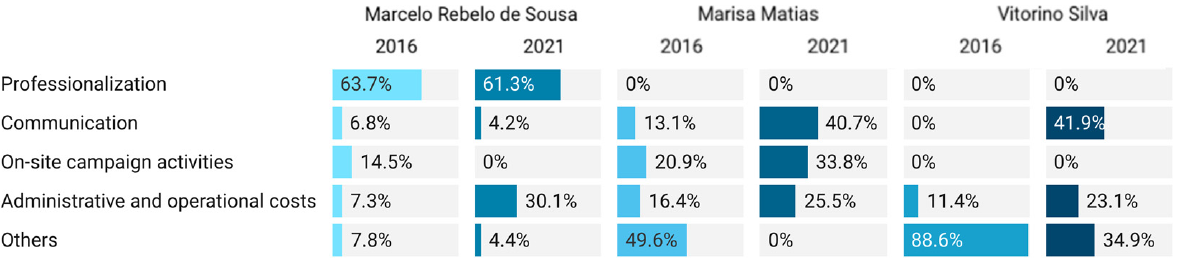
Figure 8. Investment in professionalization (actual expenses). Comparison between candidates running in both elections. Source: Own coding from ECFP (https://www.tribunalconstitucional.pt/ tc/contas_eleicoes-pr.html, accessed on 11 September 2022). Note: Absolute values are displayed in the Appendix A (Tables A1 and A2).